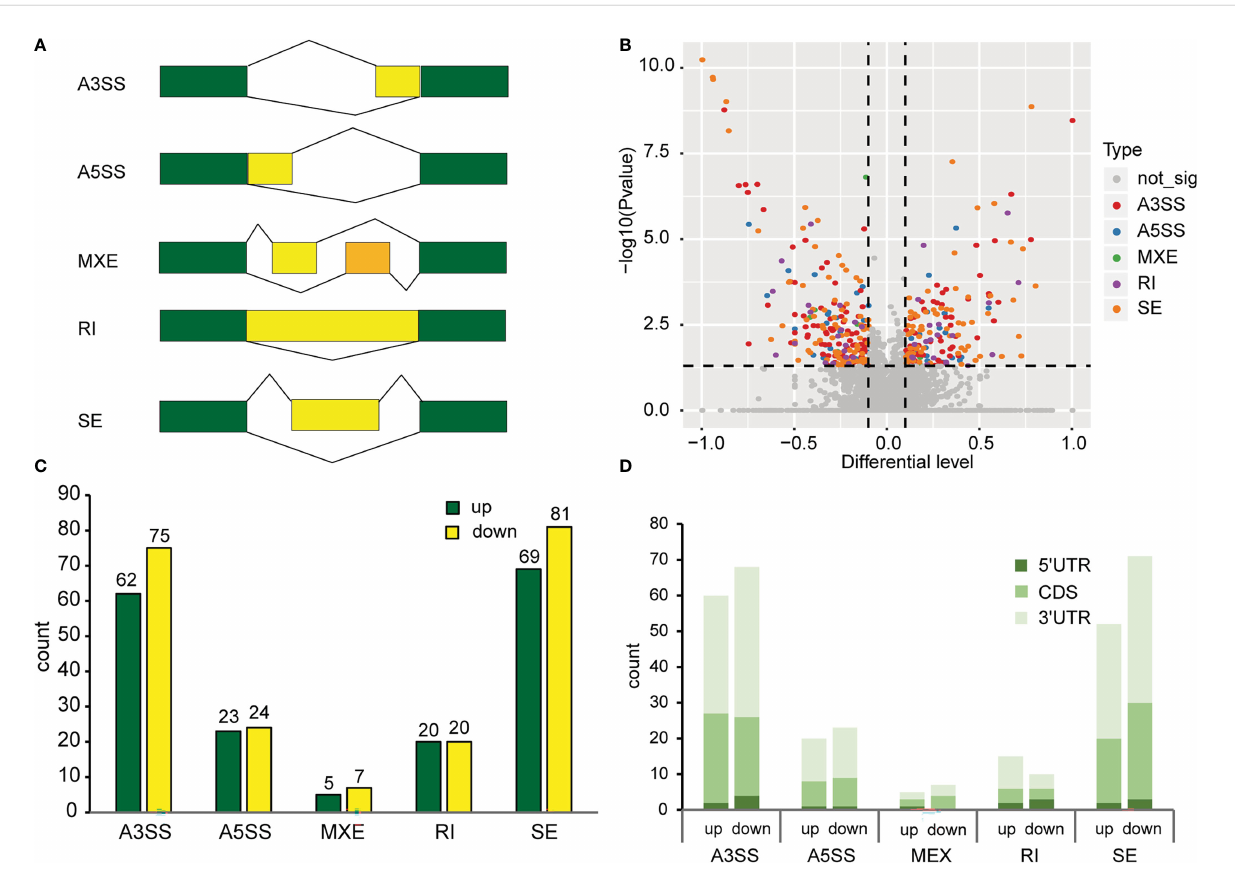
FIGURE 2 Alternative splicing events in methylated genes. (A) Types of alternative splicing events. A3SS, Alternative 3 ’ splice site; A5SS, Alternative 5 ’ splice site; MXE, Mutually exclusive exon; RI, Retained intron; SE, Skipped exon. Green boxes represent constitutive exons. Yellow boxes and orange boxes represent alternatively spliced exons. The broken lines represent the way exons are connected. (B) Analysis of differential alternative splicing. p value<0.05, | Dy |>0.05. (C) Number of different types of alternative splicing events. (D) The effect of methylation of different transcript regions on alternative